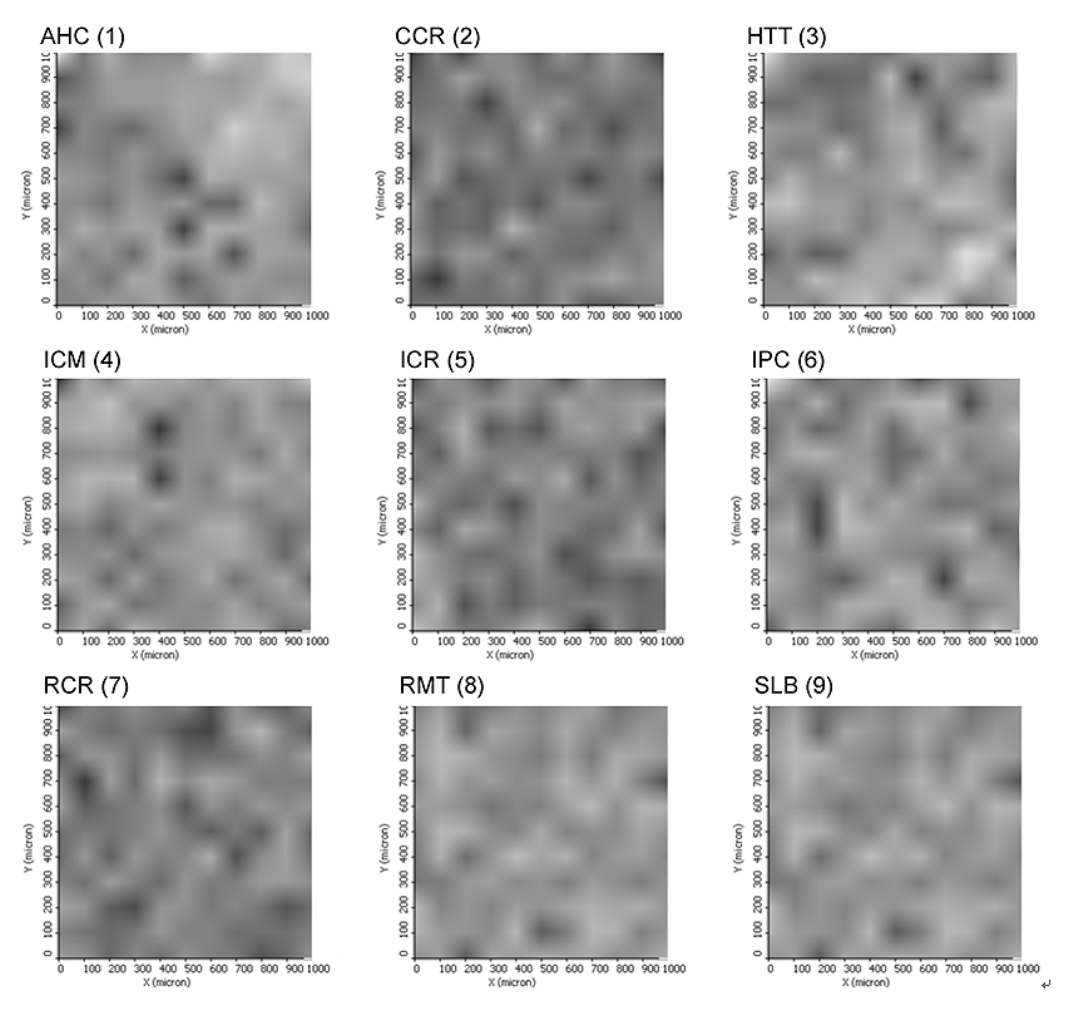
Figure 5. Mass Spectrometry Imaging (MSI) of the samples analyzed on ImageJ software for the semi-quantification. The intensity on the grayscale indicates more (darker) or less (lighter) concentration of the desired analyte. This figure also illustrates that all samples were assigned the same area for further quantitative